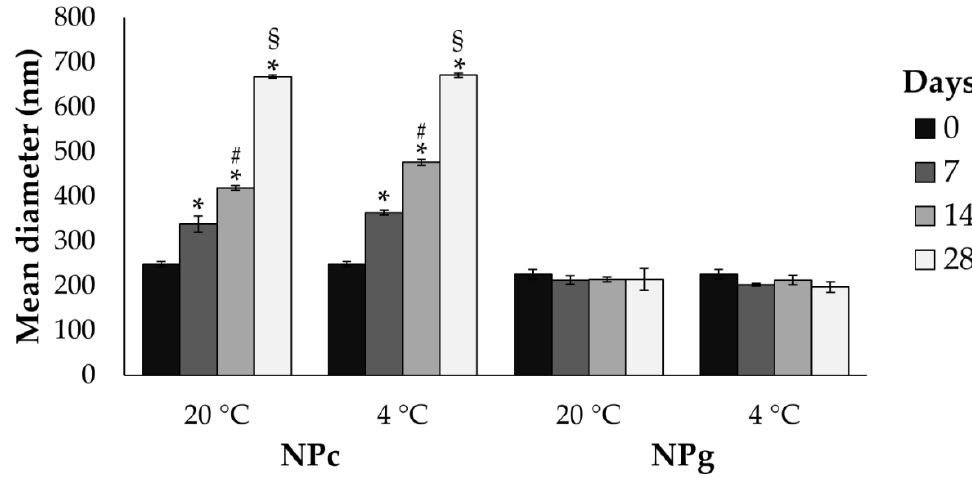
Figure 4. Particle size of NPc and NPg measured immediately after preparation (t0) and then after 7, 14, and 28 days, both stored at 20 °C and 4 °C. * p < 0.05 versus NPc t0; # p < 0.05 versus NPc t7 both at 20 °C and 4 °C; § p < 0.05 versus NPc t14 both at 20 °C and 4 °C; $ p < 0.05 versus NPg t0.